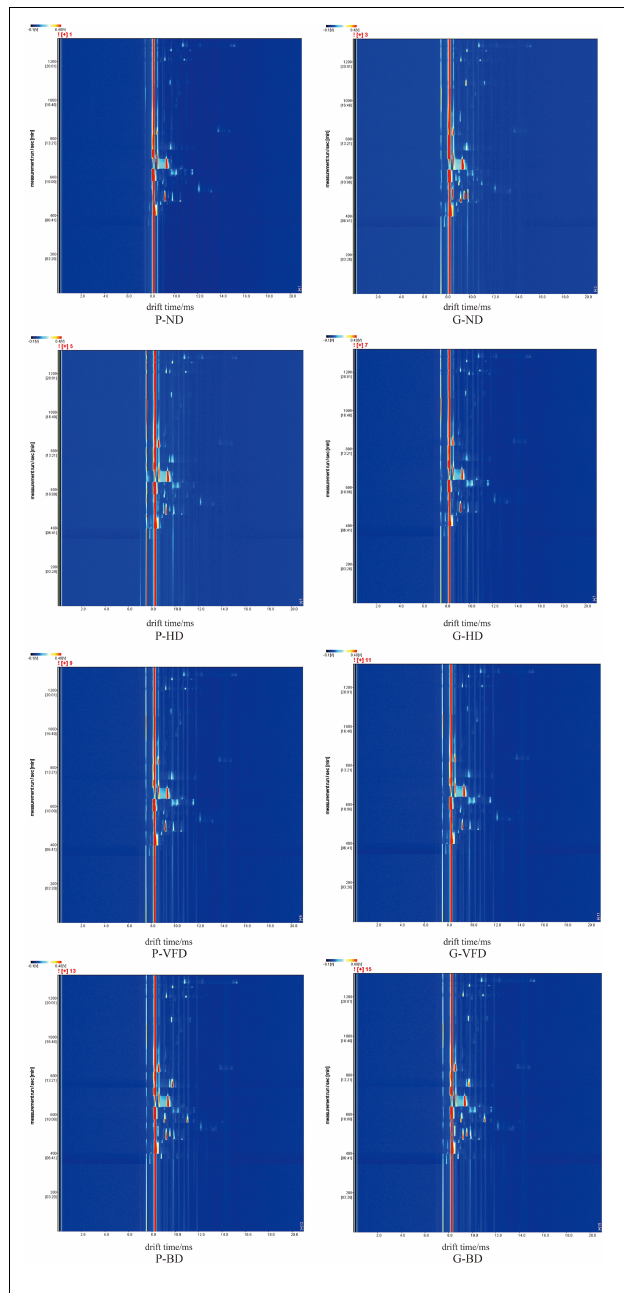
FIGURE 1 | Two-dimensional overview of the gas phase-ion migration of volatile compounds in asparagus roots with different drying methods. P, common variety; G, Guidong no. 1 variety; ND, natural drying; HD, heat pump drying; VFD, vacuum freeze-drying; and BD, blast drying.